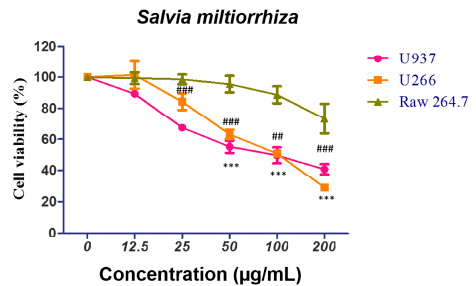
Figure 1. Salvia miltiorrhiza (SM) exerts a cytotoxic effect on U266 and U937 cells. Raw264.7 (murine macrophage), U266 (human multiple myeloma), and U937 (human myeloid leukemia) cells were grown in microplates (96 wells) at a density of 2 × 10 4 cells/well. Those cell lines were treated with the indicated concentrations of SM (0, 12.5, 25, 50, 100, or 200 µg/mL) for 24 h. Cell viability was assessed by an EZ-cytox enhanced cell viability assay kit. Values represent the means of three experiments ± SD; ## , p < 0.01; ### , p < 0.001 versus an untreated control group (U937 cells); ***, p < 0.001 versus untreated control group (U266 cells).